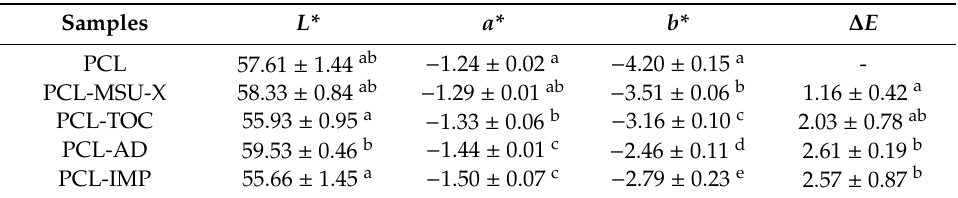
Table 4. CIELab colour parameters obtained in PCL-based films.